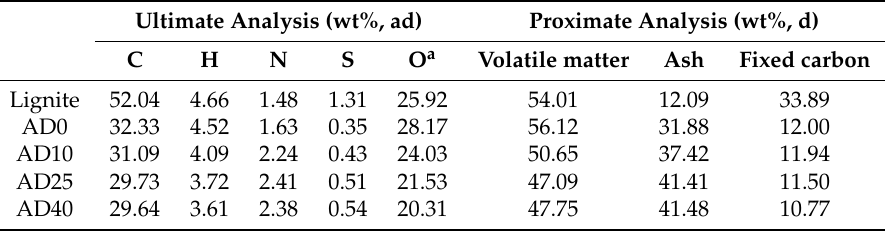
Figure 3. ( a ) TG and ( b ) DTG curves of lignite and AD digestate samples. Table 2. Ultimate and proximate analysis of the digestate and